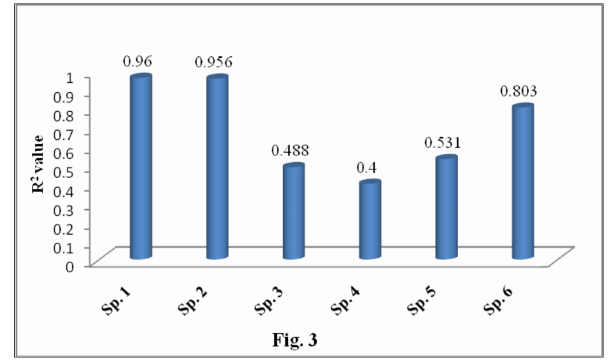
Fig. 3. Comparison of correlation